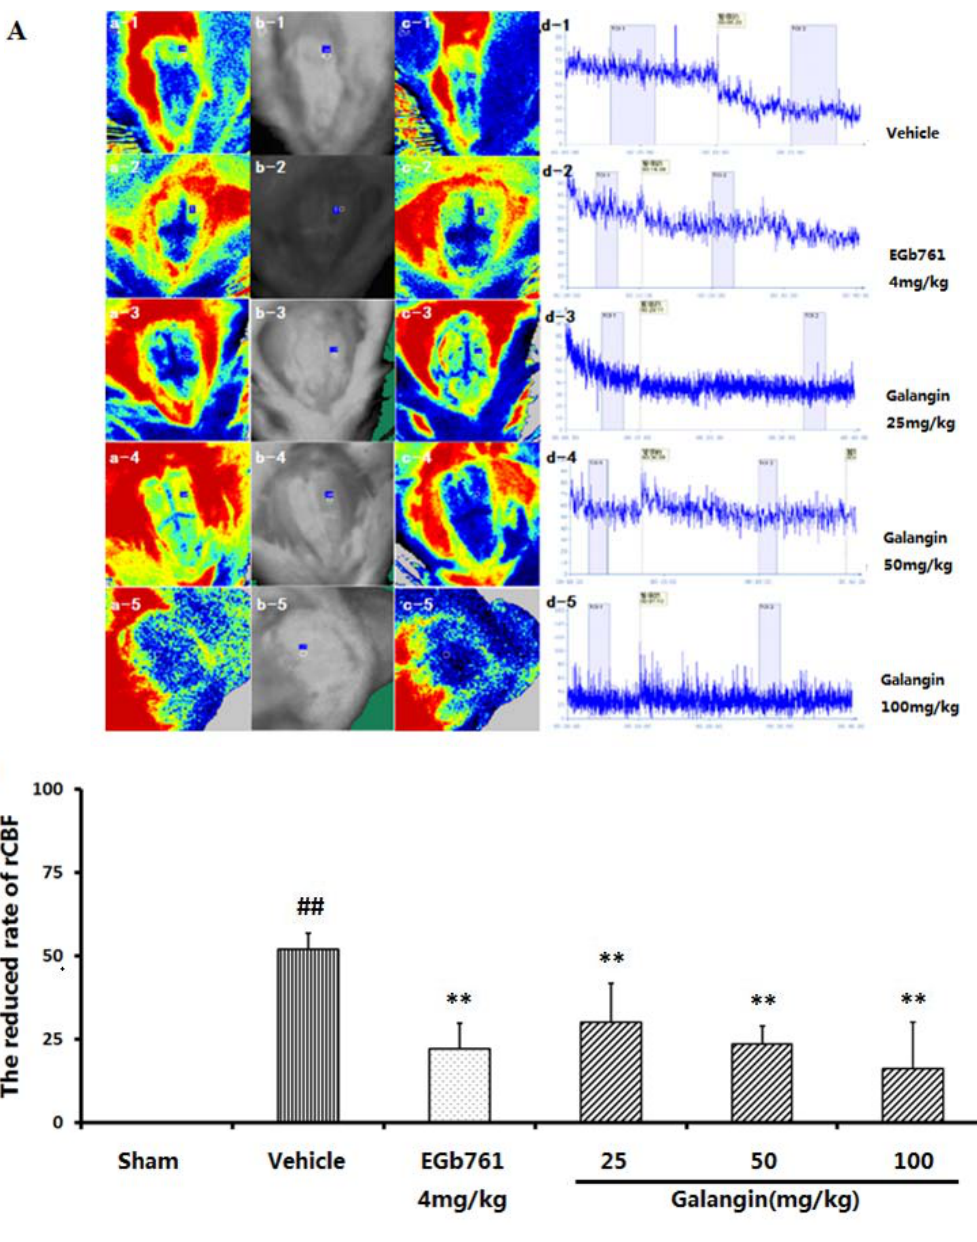
Figure 3. Effects of galangin on the rCBF of rats induced by MCAO. EGb761 and galangin were both administered by i.g. 15 min prior to MCAO. ( A ) Detection of cerebral blood flow. The cerebral blood flow perfusion color image (Figure 3A.a1–5 and c1–5), detected position image (Figure 3A.b1–5), and blood flow time window (Figure 3A.d1–5) were presented (1, Vehicle control; 2, EGb761-treated group; 3–5: galangin- (25, 50 and 100 mg·kg − 1 ) treated group); ( B ) The reduced rate of rCBF. The values were expressed as the mean ± SD (n = 5), and the data were analyzed by one-way ANOVA. ## p < 0.01, # p < 0.05 versus the sham group; ** p < 0.01,* p < 0.05 versus the vehicle